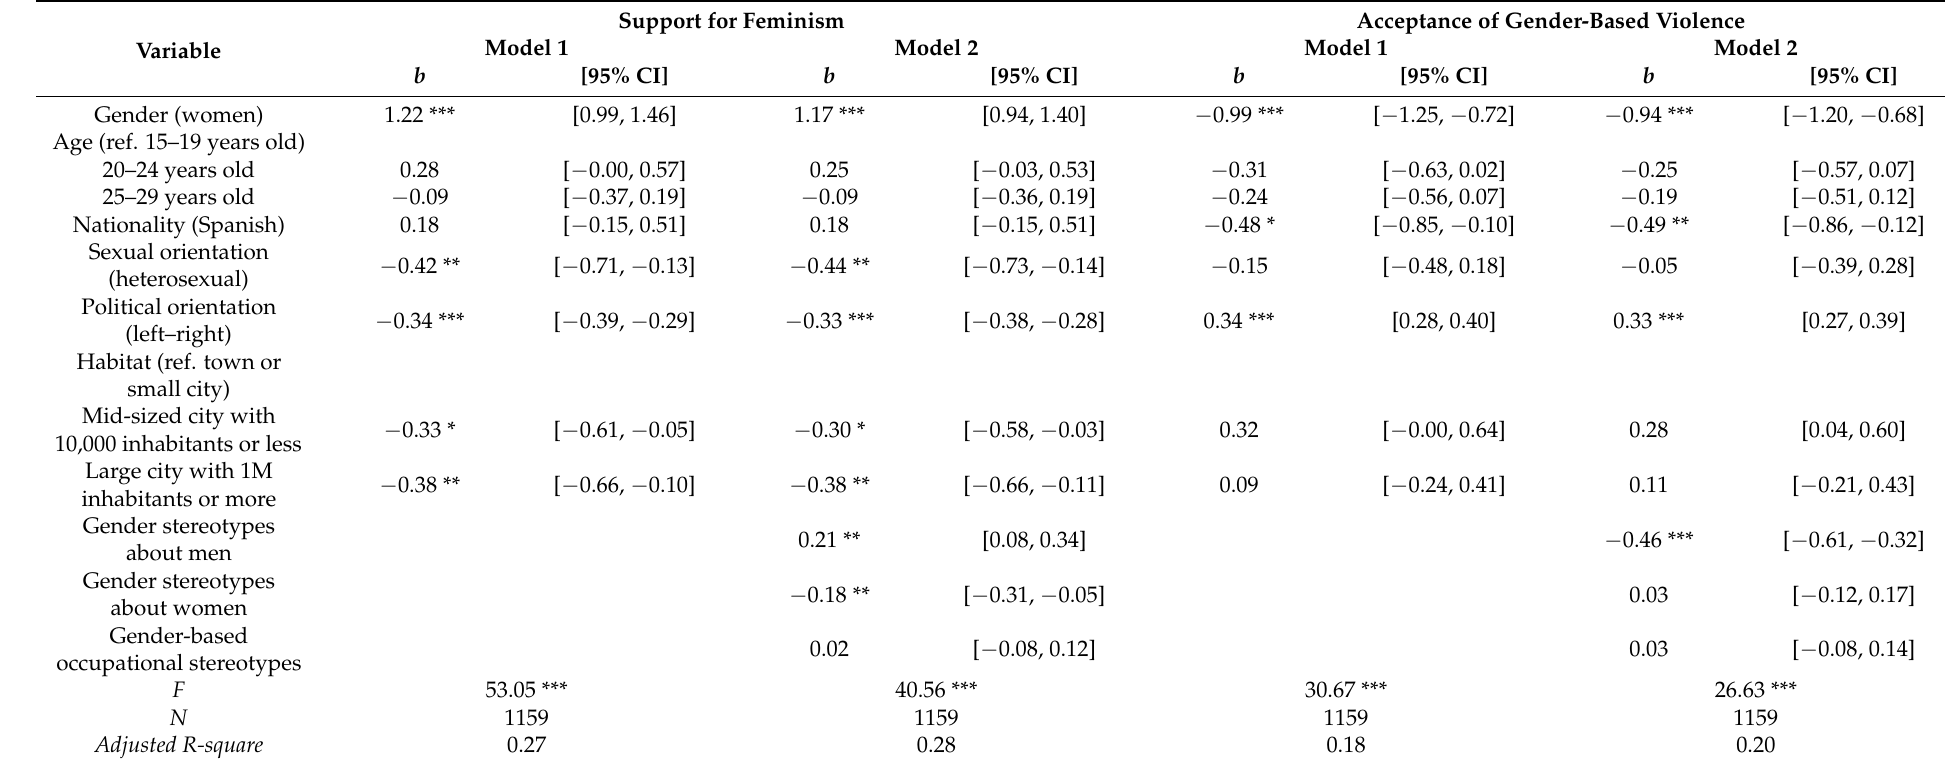
Table 6. Correlates of support for feminism and acceptance of gender-based violence (multiple linear regression